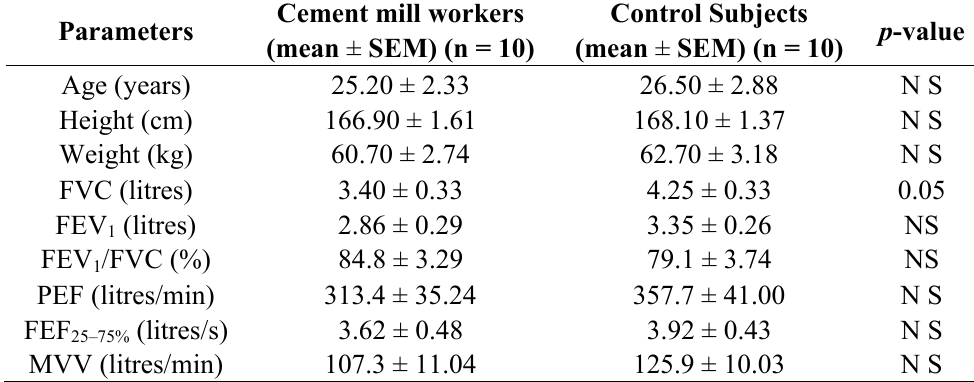
Table 1: Anthropometric and lung function data for cement mill workers with duration of exposure less than five years compared with their matched controls.